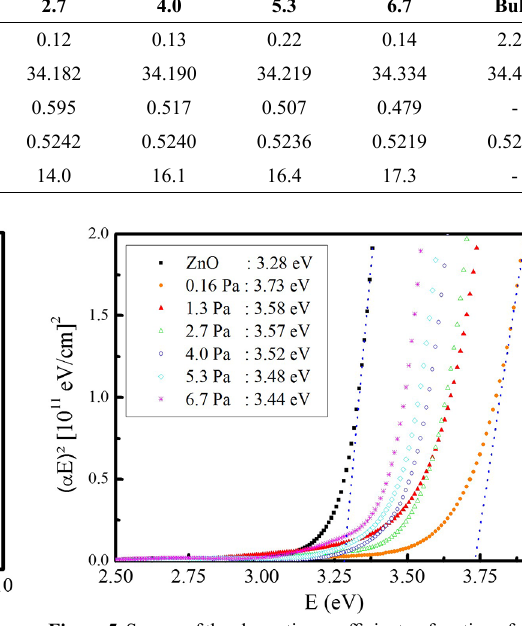
Figure 5. Square of the absorption coefficient as function of photon energy for AZO thin films grown at different sputtering